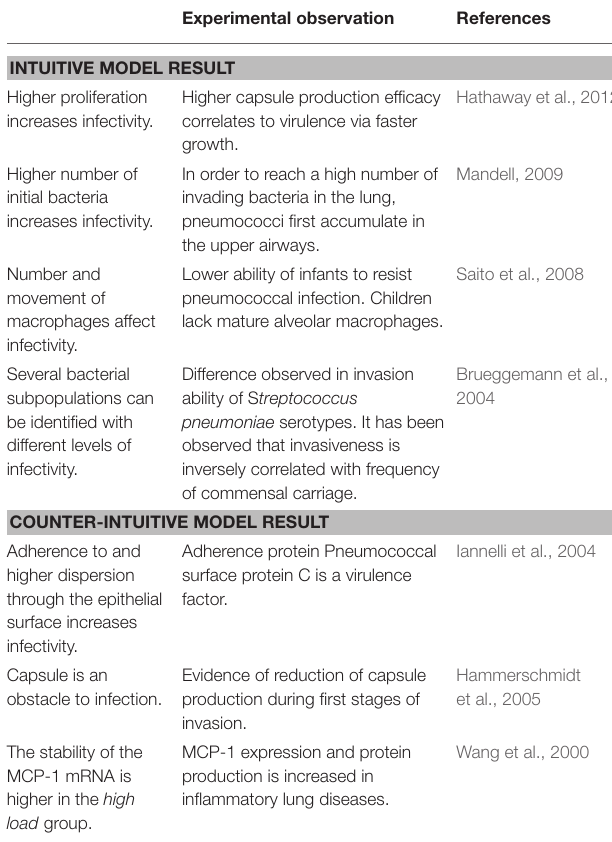
TABLE 2 | List of model predictions that are linked to published experimental